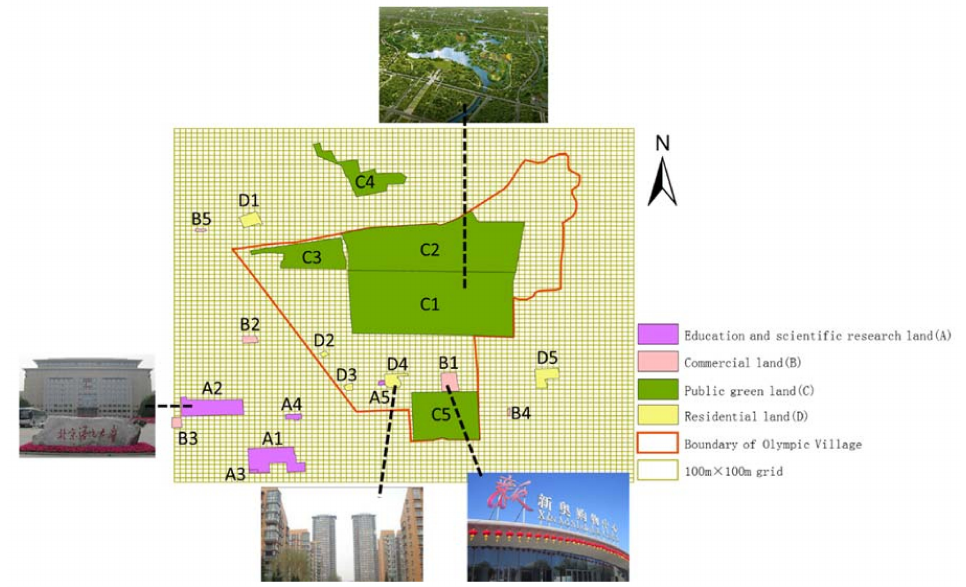
Figure 7. Spatial distribution of land used for ( A ) education and scientific research, ( B ) commercial uses, ( C ) public green space, and ( D )